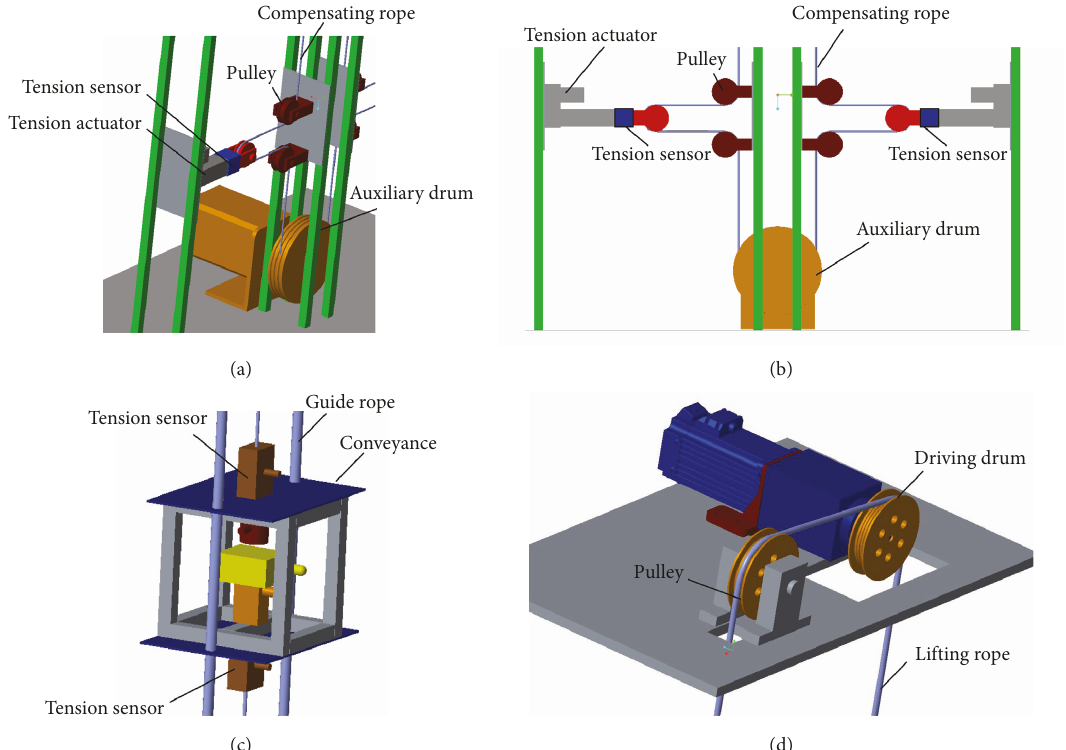
Figure 2: Installation schematic. The (a) system for applying tension on the compensating rope (unilateral schematic), (b) system for applying tension on the compensating rope (bilateral schematic), (c) conveyance, and (d) drum and